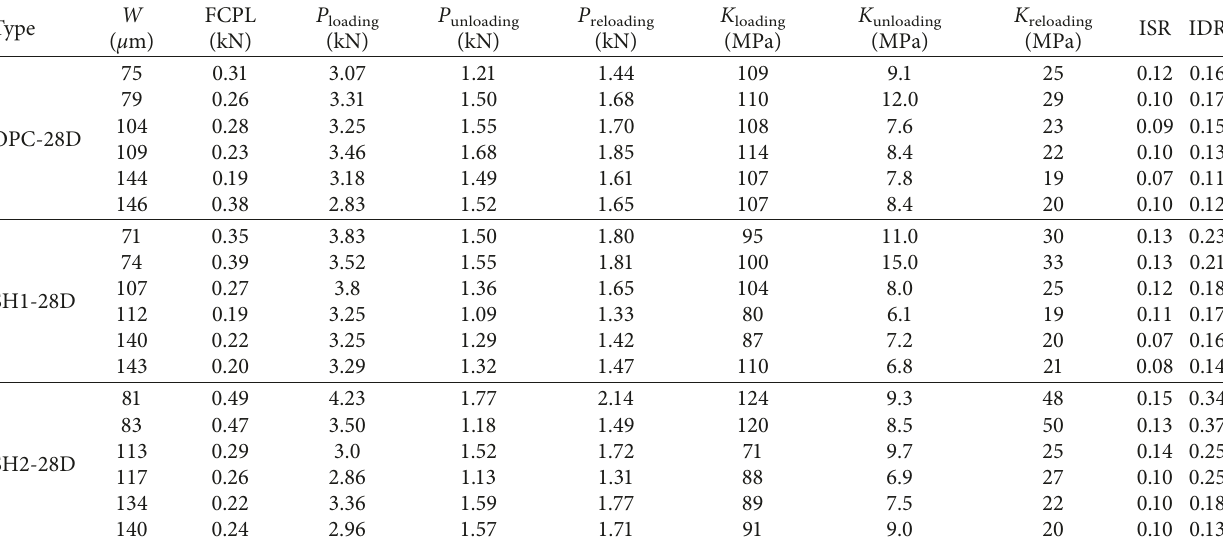
Table 2: Mechanical recovery indices for three mixes at 28days of healing.